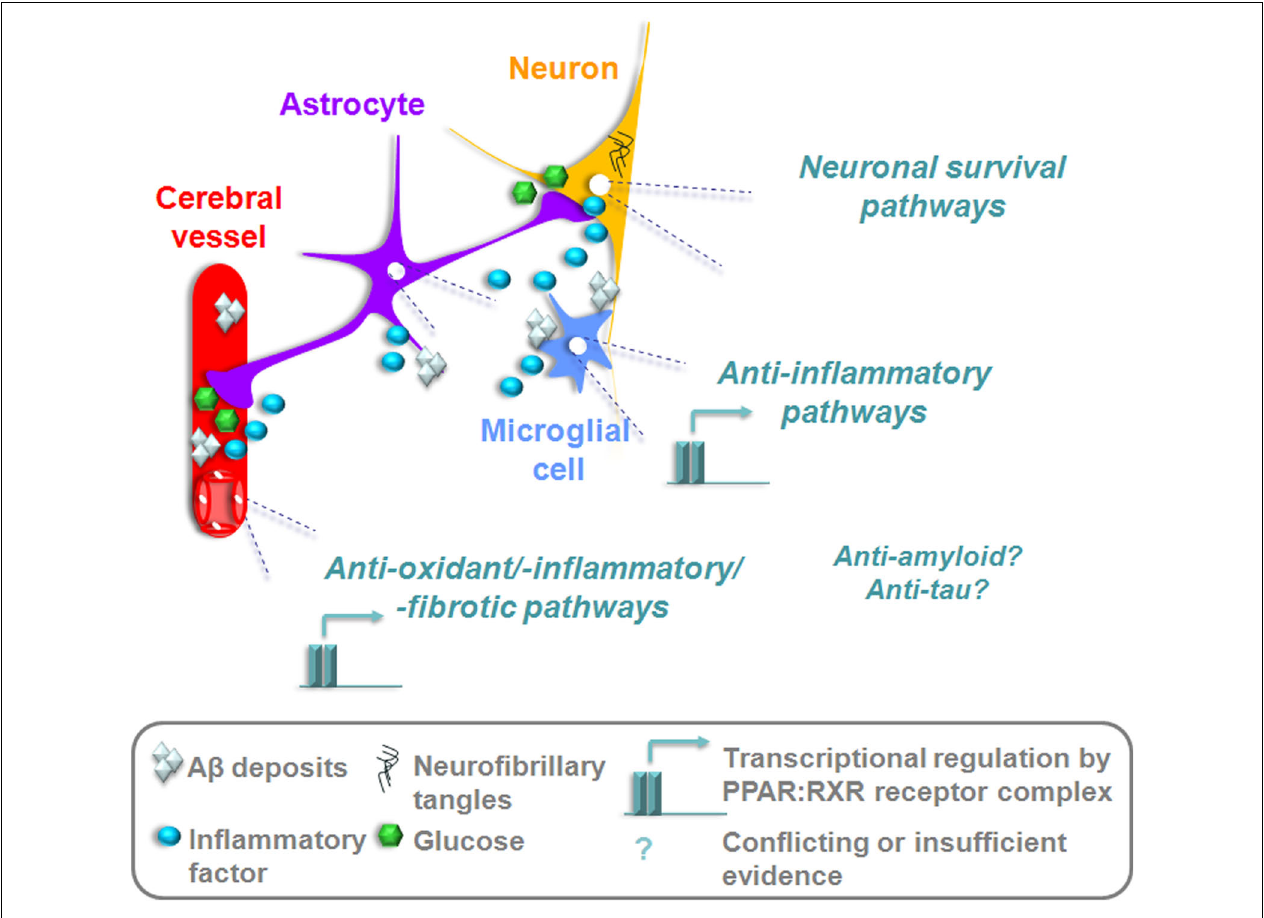
of passing the BBB could upregulate anti-apoptotic factors in neurons, re-sensitize cells to insulin and restore glucose utilization. The potential to counter amyloidogenesis and τ hyperphosphorylation could be disease- modifying, but requires further empirical support and confi rmation in